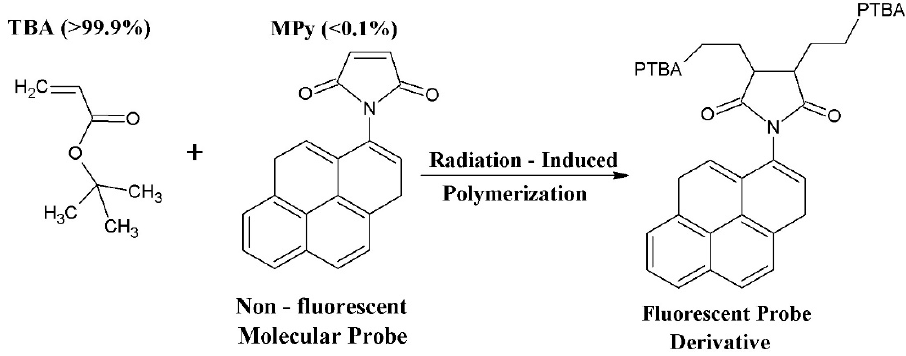
Figure 1. A schematic of the reaction mechanism underlying the radio-fluorogenic effect.